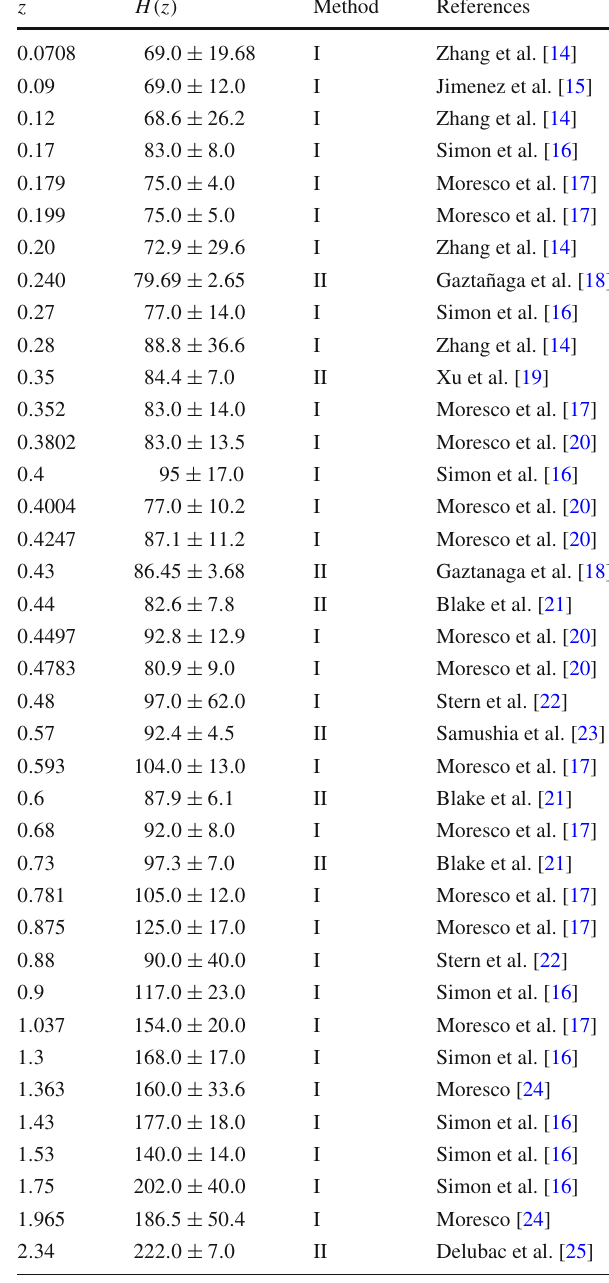
Table 1 The current available OHD dataset. The method I is the differ- ential ages method, and II represents the radial Baryon acoustic